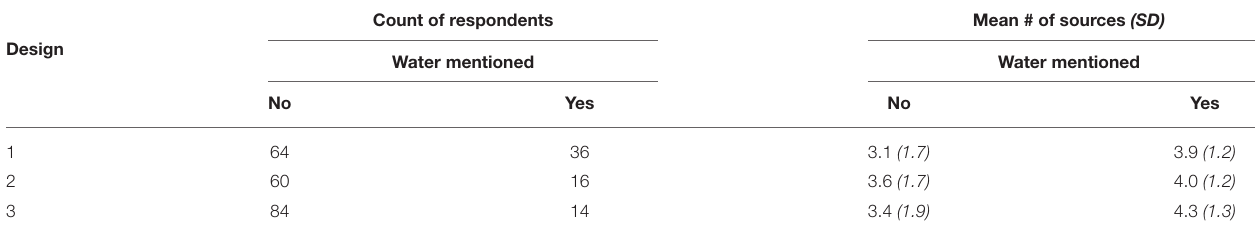
TABLE 7 | Comparison of the mean number of sources mentioned when water is one of them and when it is not (standard deviation in italics). Count of Design